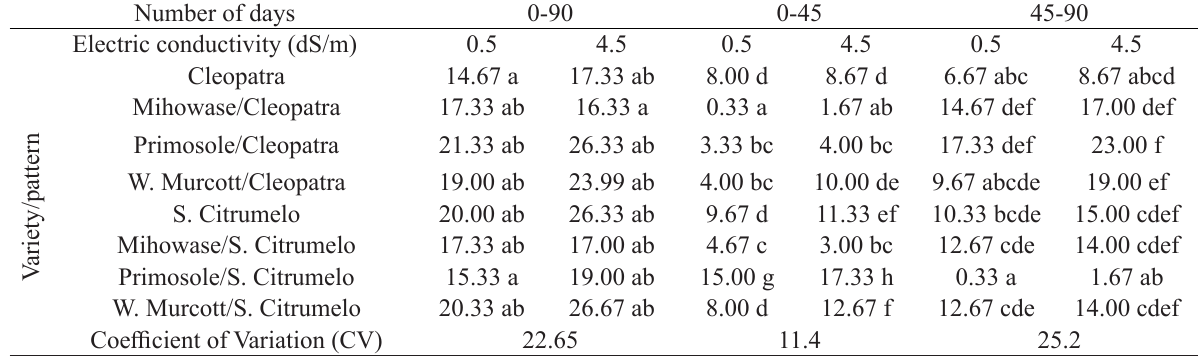
Table 1. Duncan test of the effects of salts stress on the leaves loss of each scion/rootstock combination a 45 and 90